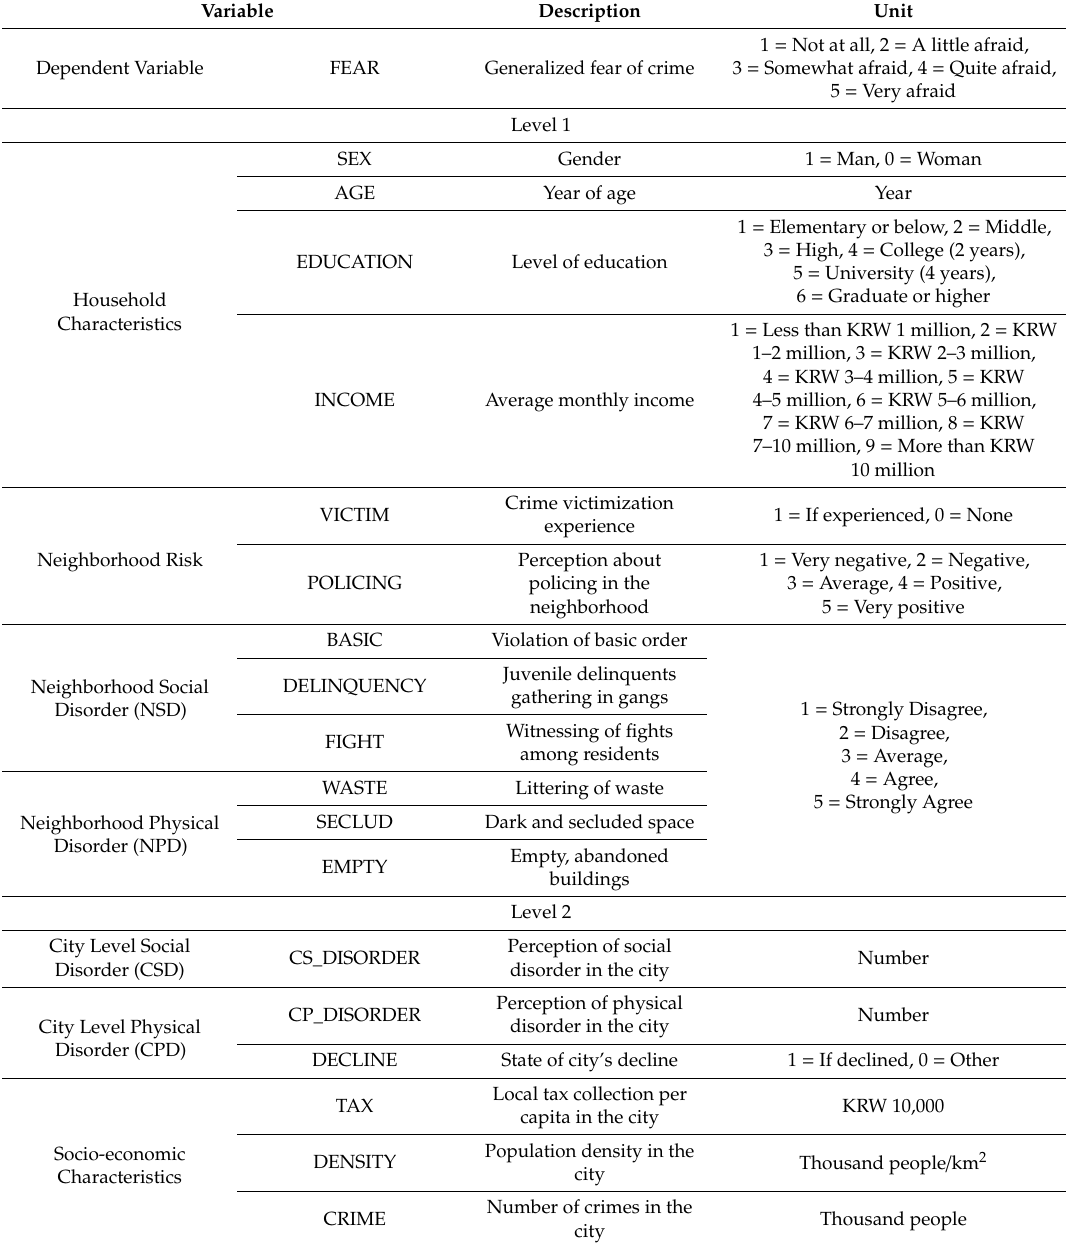
Table 4. Description of